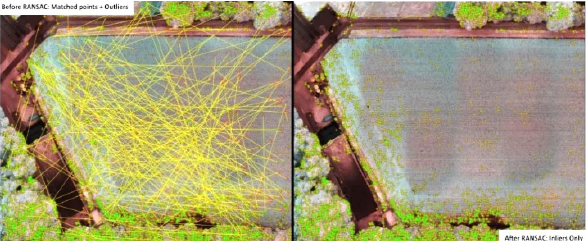
Figure 5. Showing putative matched plus outliers (left), and only the correct matches and inliers